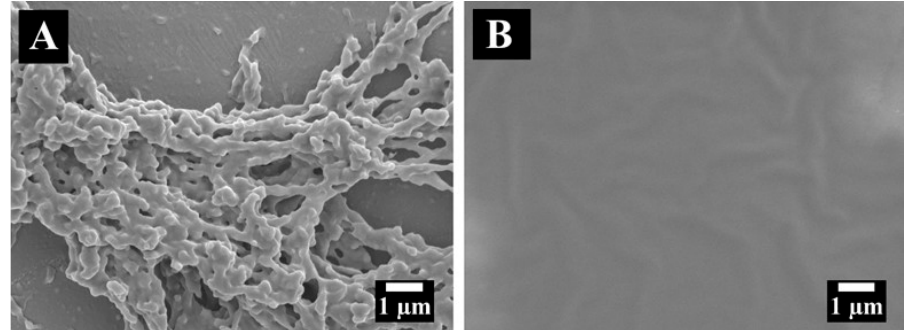
Figure 2. SEM micrographs for a film, prepared from 10 gL − 1 PEMA with 1 gL − 1 LA solution: ( A ) as- deposited and ( B ) after annealing at 180 °C for one hour.